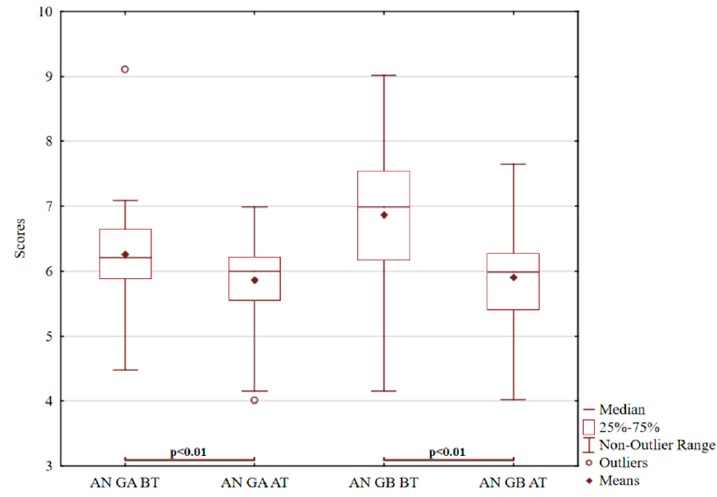
Figure 2. ROR for animal interpretation.